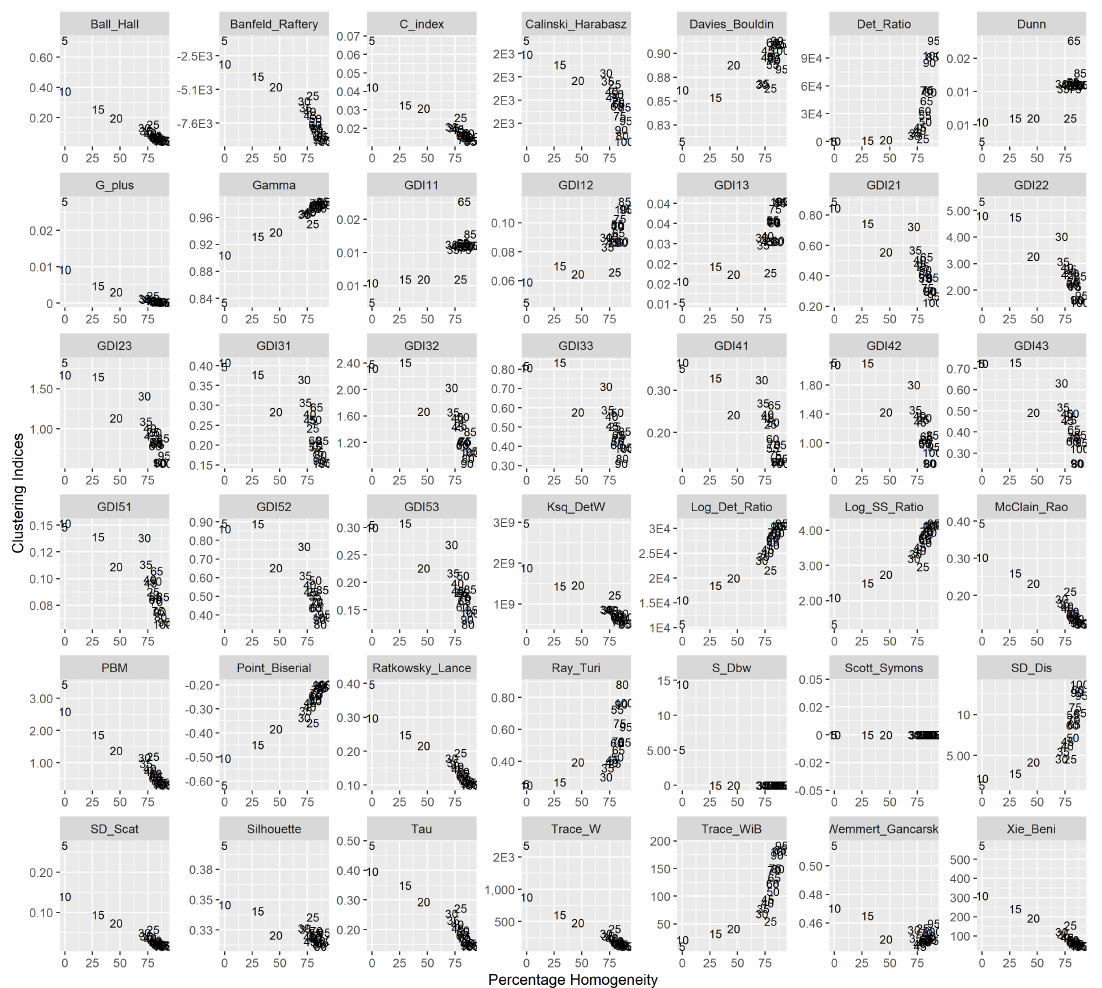
Figure 5. Performance of cluster validity indices in Prairie region—Winter season. The numbers indicate the percentage homogeneity for the number of clusters in the x-axis and index value on the y-axis. The scientific notation ‘E’ used in labels of y-axis represent ‘10 to the power